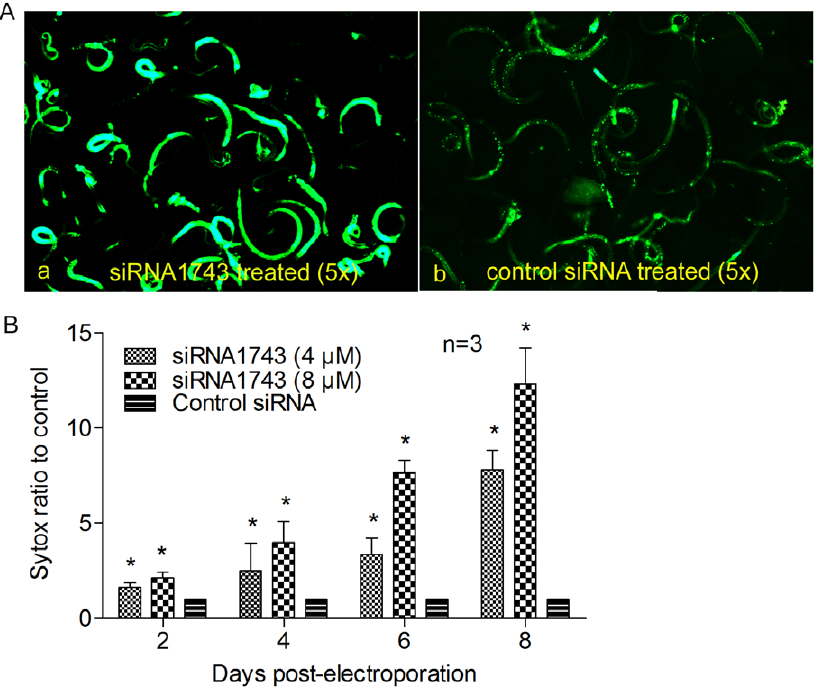
Figure 6. Suppression of Ts - pmy mRNA expression by siRNA1743 caused surface damage and defected viability of treated larvae. The larvae treated with siRNA1743 for 6 day were stained with SYTOX for 15 min and then observed under fluorescence microscopy (A) or measured with a fluorescence microplate reader at 485 nm excitation and 530 nm emission (B). All of the assays were performed in triplicate. * p , 0.05 compared with the control siRNA-treated group.